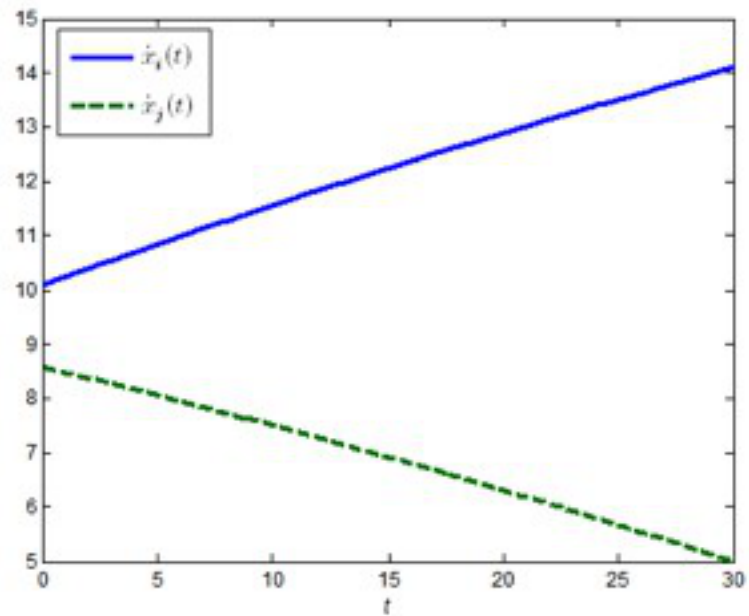
Figure 2. Demand rates over time of two types of